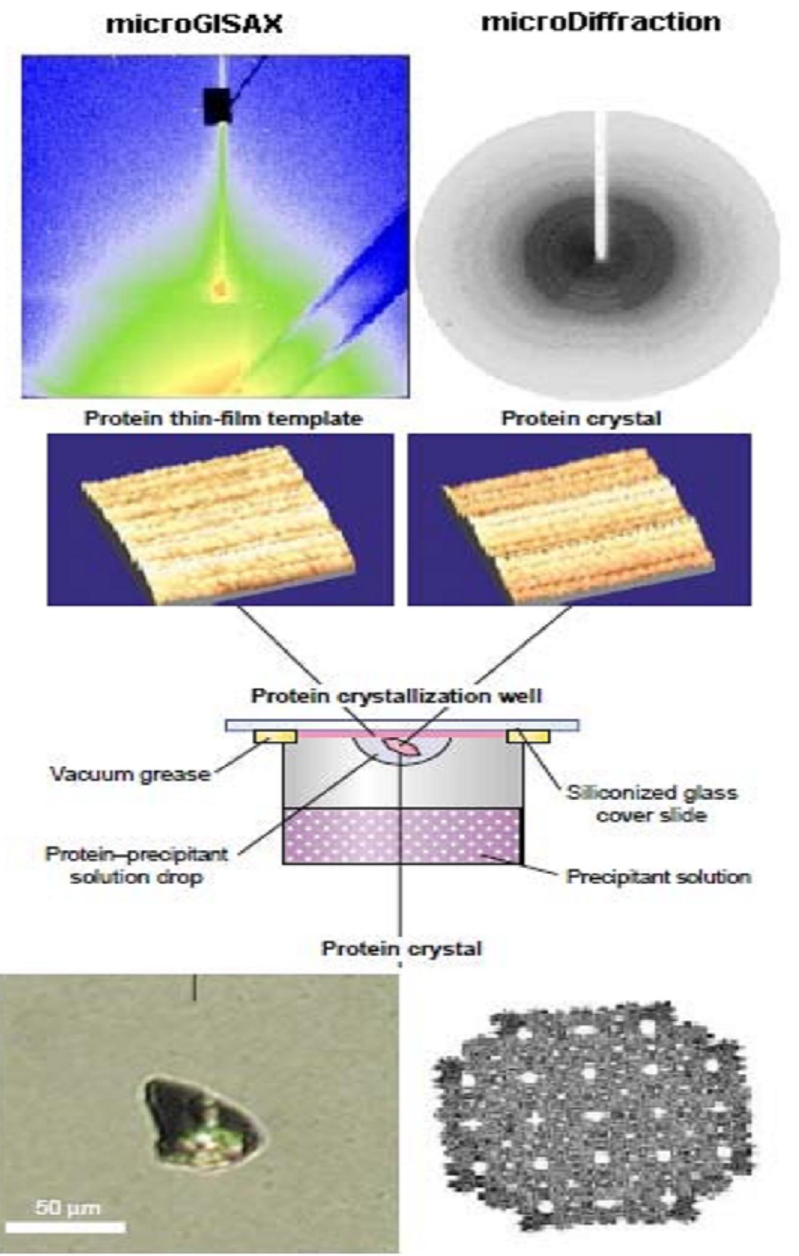
Figure 5. LB-based protein crystals preparation and